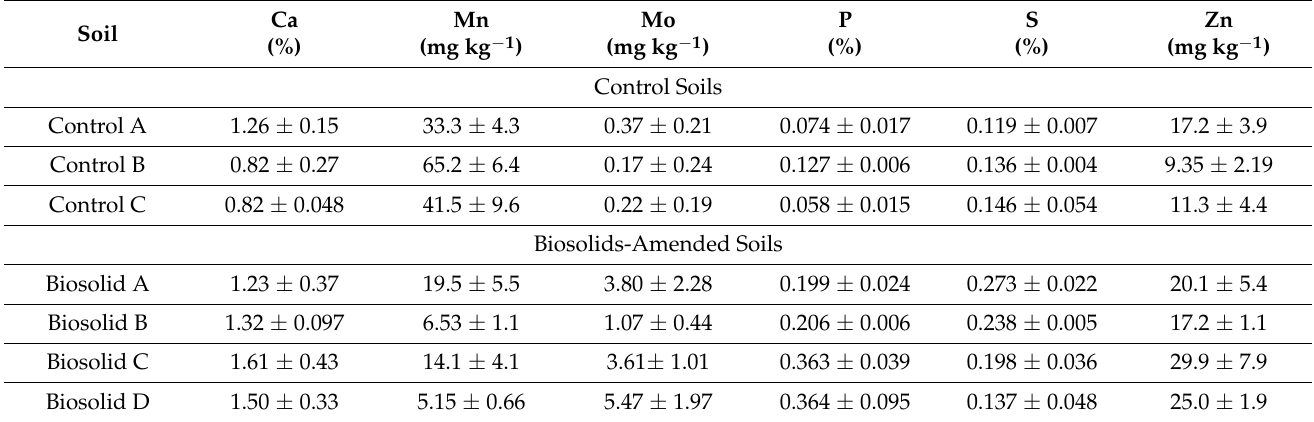
Table 6. Concentrations of macronutrients (%) and trace metals (mg kg − 1 ) in radish shoots grown in biosolids-amended and control